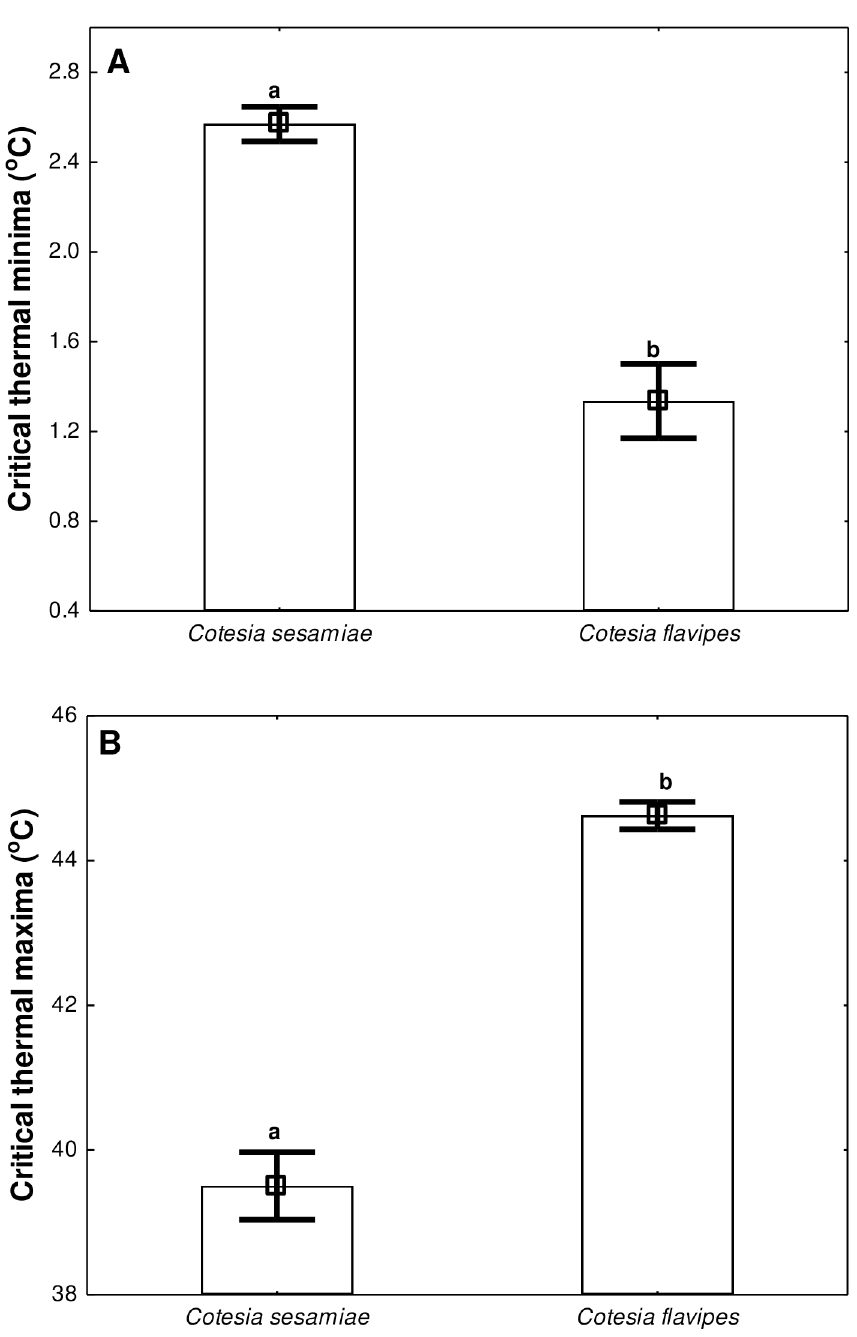
Fig 2. Effects of species ( Cotesiasesamiae and Cotesiaflavipes )on (A) Critical thermal minima and (B) Critical thermal maxima. Error bars represent 95% confidence limits (N = 20). Means with the same letter are not significantly different from each